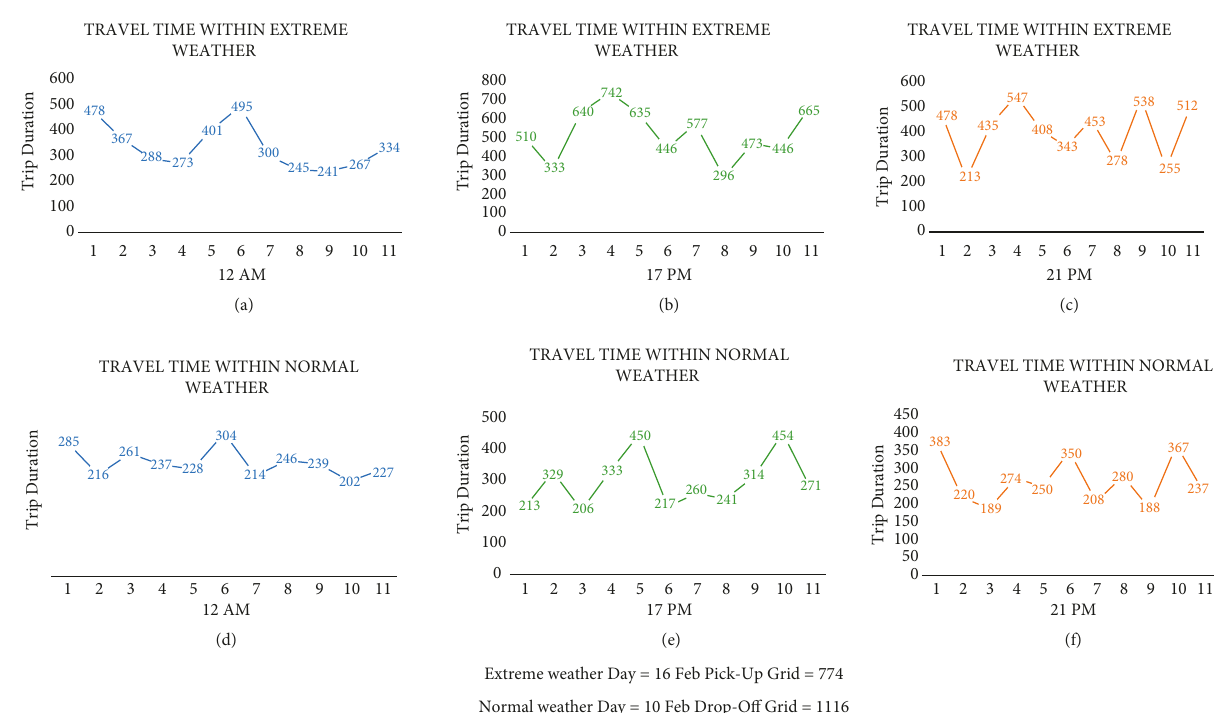
Figure 3: Visualization of travel time changes when the weather is different, for example, from pick-up grid-id id 1116 on the NYC dataset on two different days over the same time (cid:29)